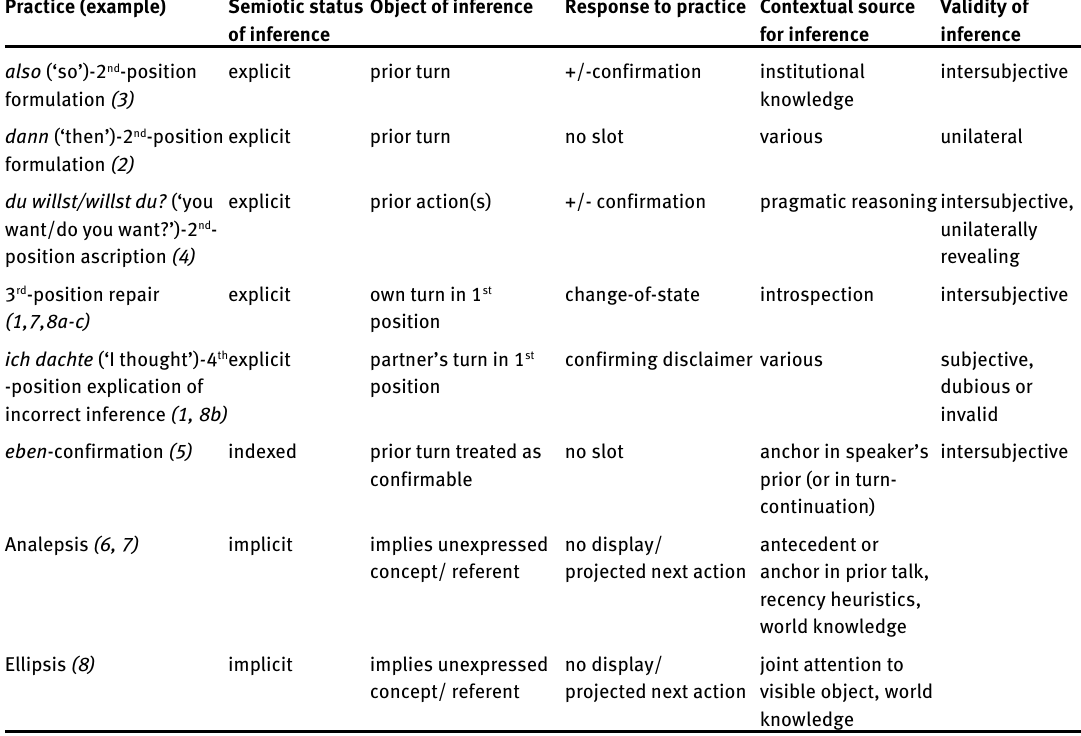
Table 1: Constituents of inferential practices in interaction Practice